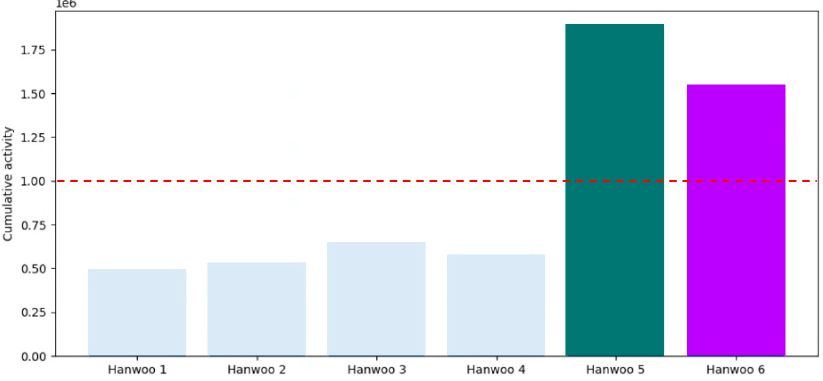
Figure 13. Cumulative activity data.